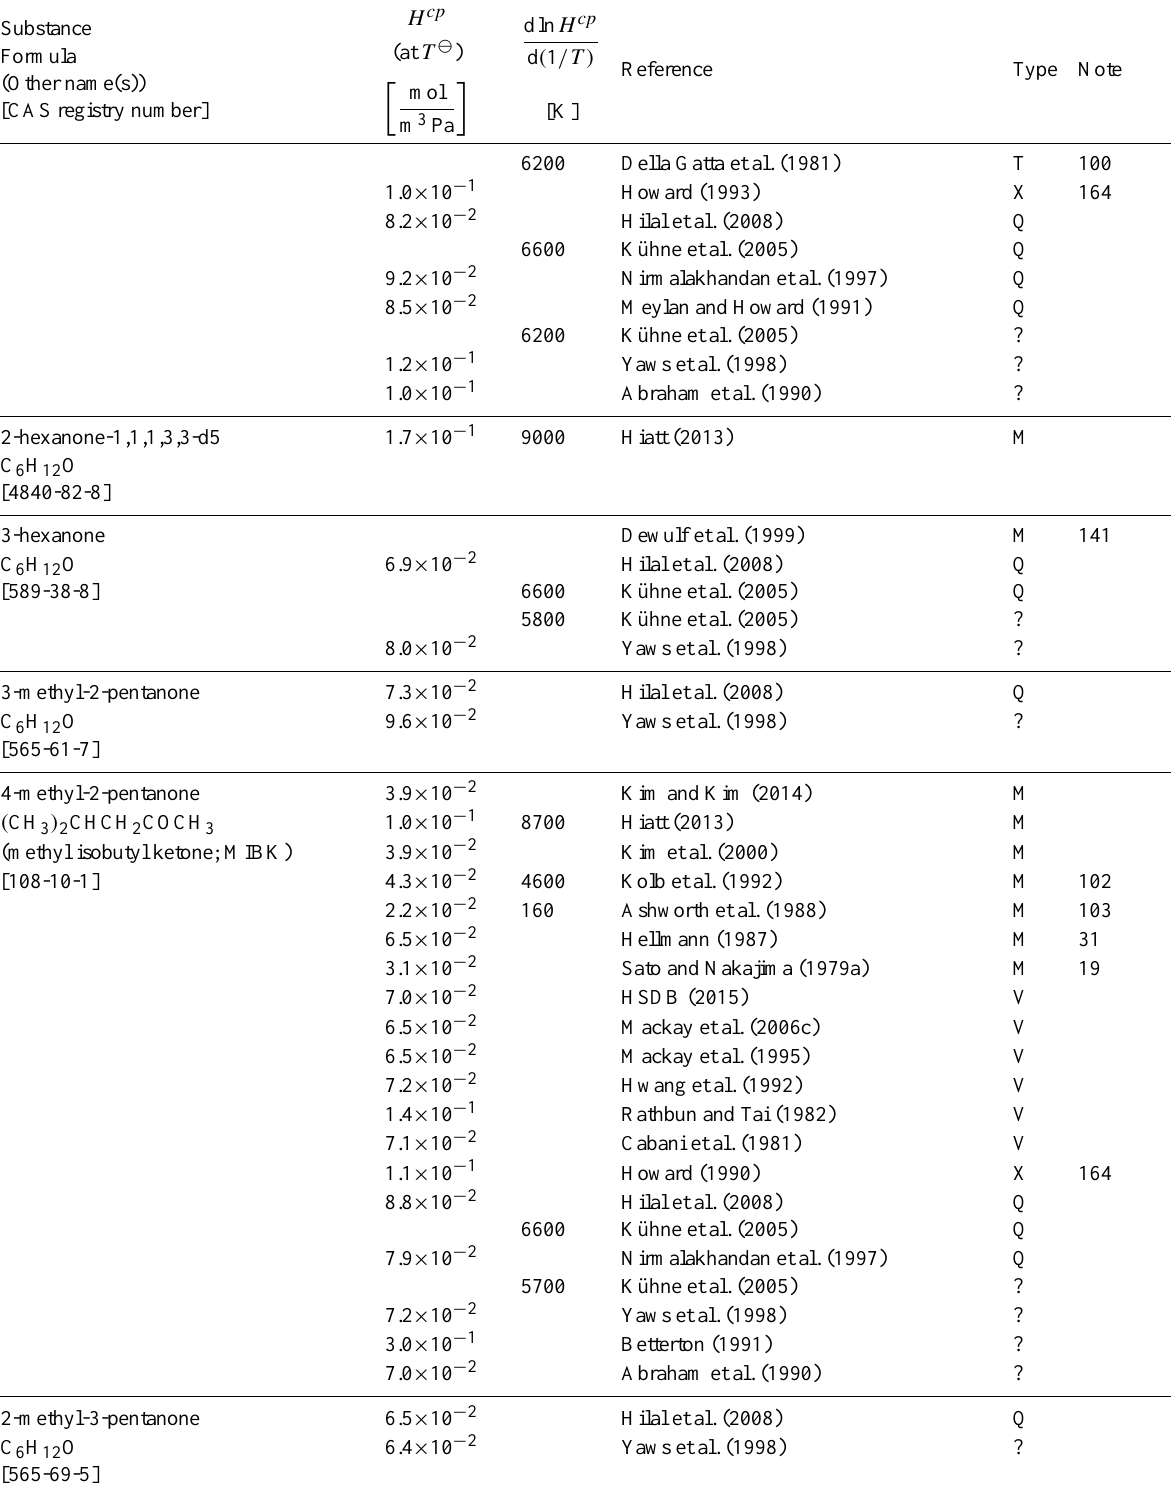
Table 6: Henry’s law constants for water as solvent